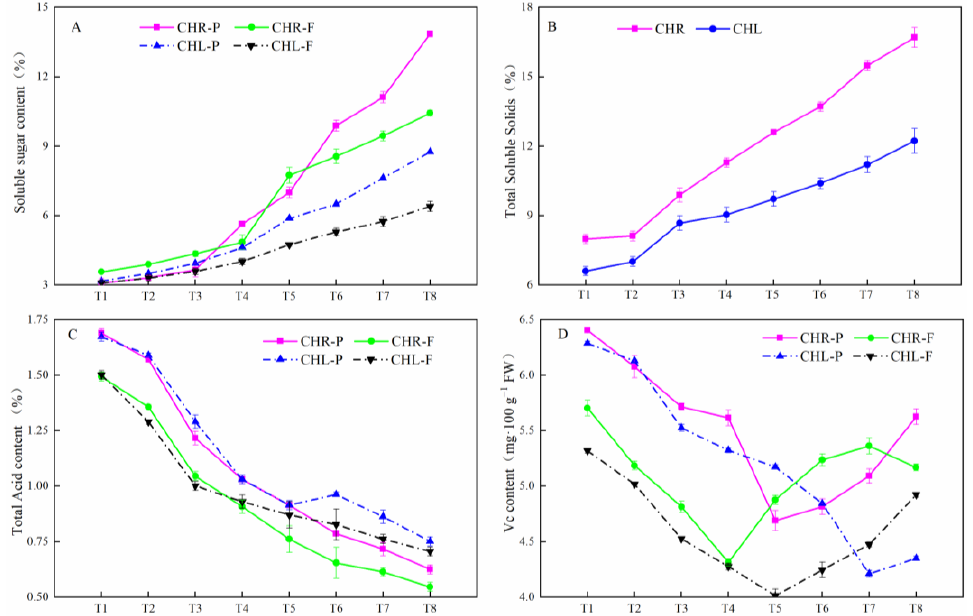
Figure 3. Changes in soluble sugar contents (SS), Total soluble solids (TSS), Total acid contents (TA), and Vc contents during the development of plums. ( A ) SS; ( B ) TSS; ( C ) TA; ( D ) Vc contents. CHR-P and CHL-P represent the skin of ‘Cuihongli Red’ and ‘Cuihongli’, respectively. Each value is the mean for three replicates. The vertical bar indicates the standard error.